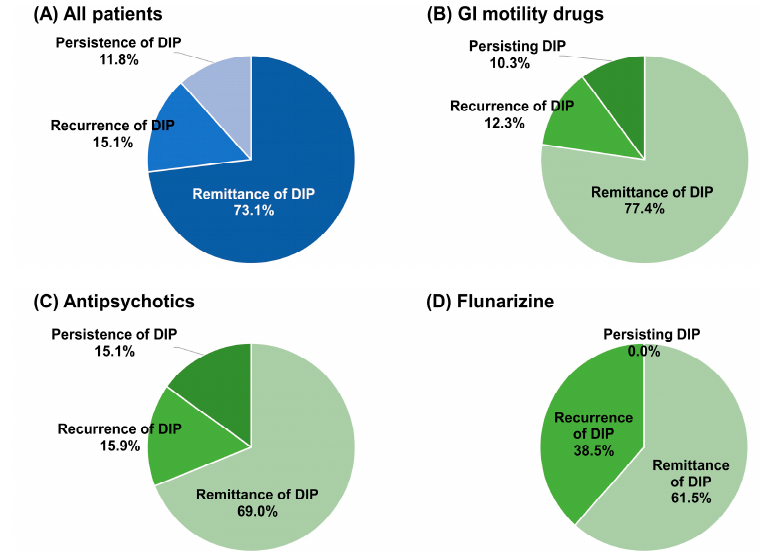
Figure 3. Prognosis after incident drug-induced parkinsonism. Abbreviations: DIP, drug-induced parkinsonism; GI, gastrointestinal.